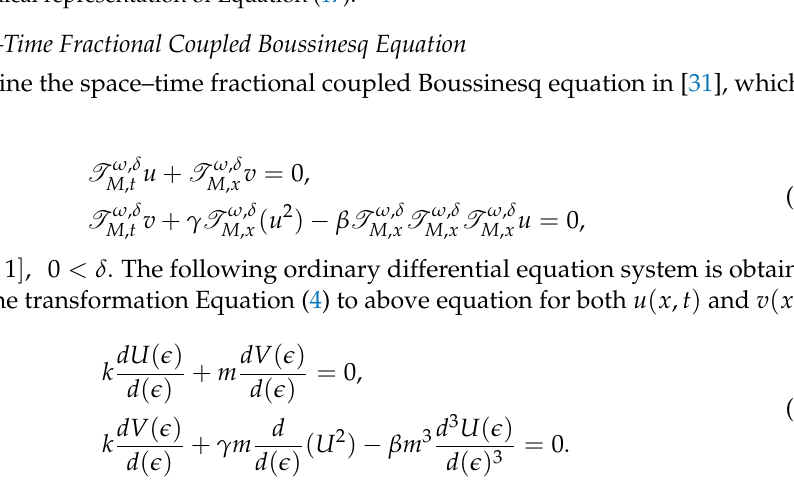
Figure 1. Graphical representation of Equation